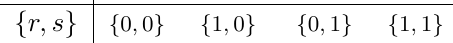
Table 2 . Parameters r, s for different NS